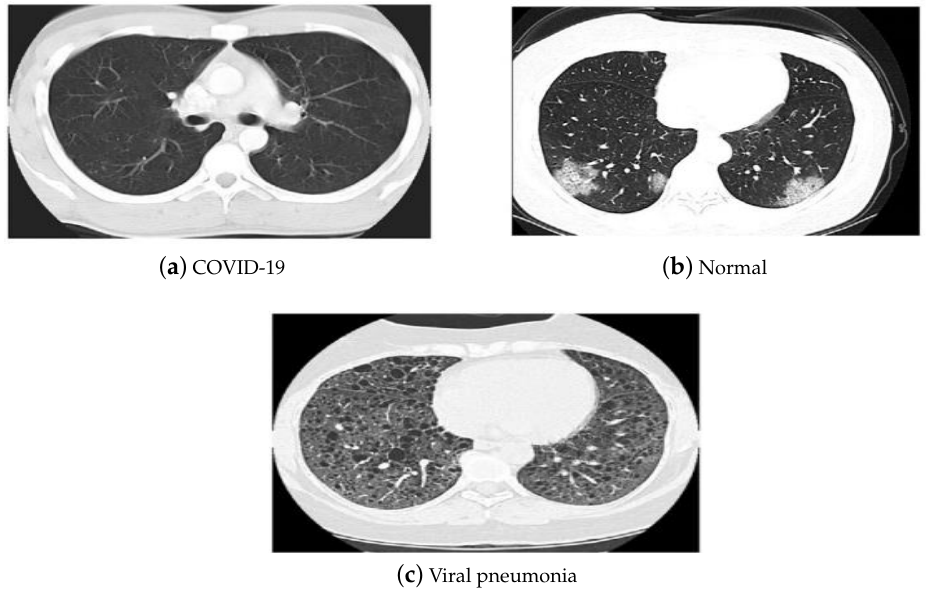
Figure 5. ( a – c ) CT data set samples